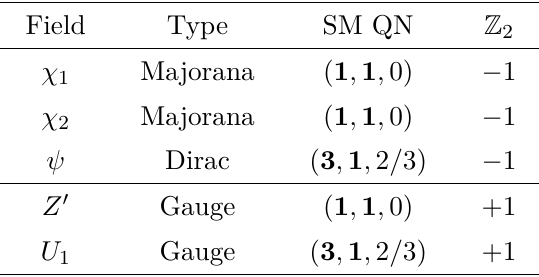
Table 1 . The new fermions and bosons we introduce in our simplified model with their quantum numbers under the SM gauge group and the stabilising Z